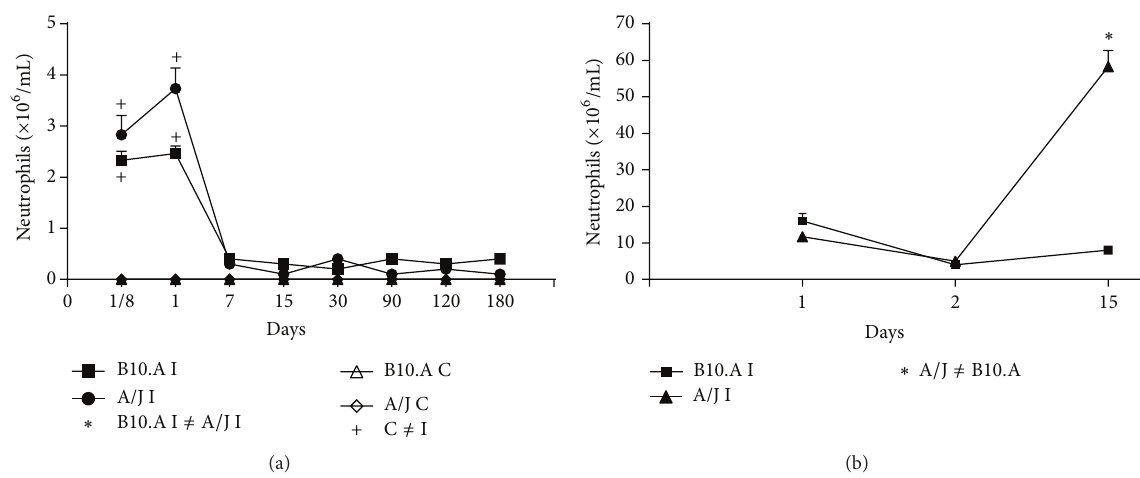
Figure 4: Neutrophilic infiltrates in peritoneum and subcutaneous exudate of A/J resistant and B10.A susceptible mice: (a) kinetics of PMN infiltration in peritoneum; (b) kinetics of PMN infiltration inside subcutaneous air-pouches.